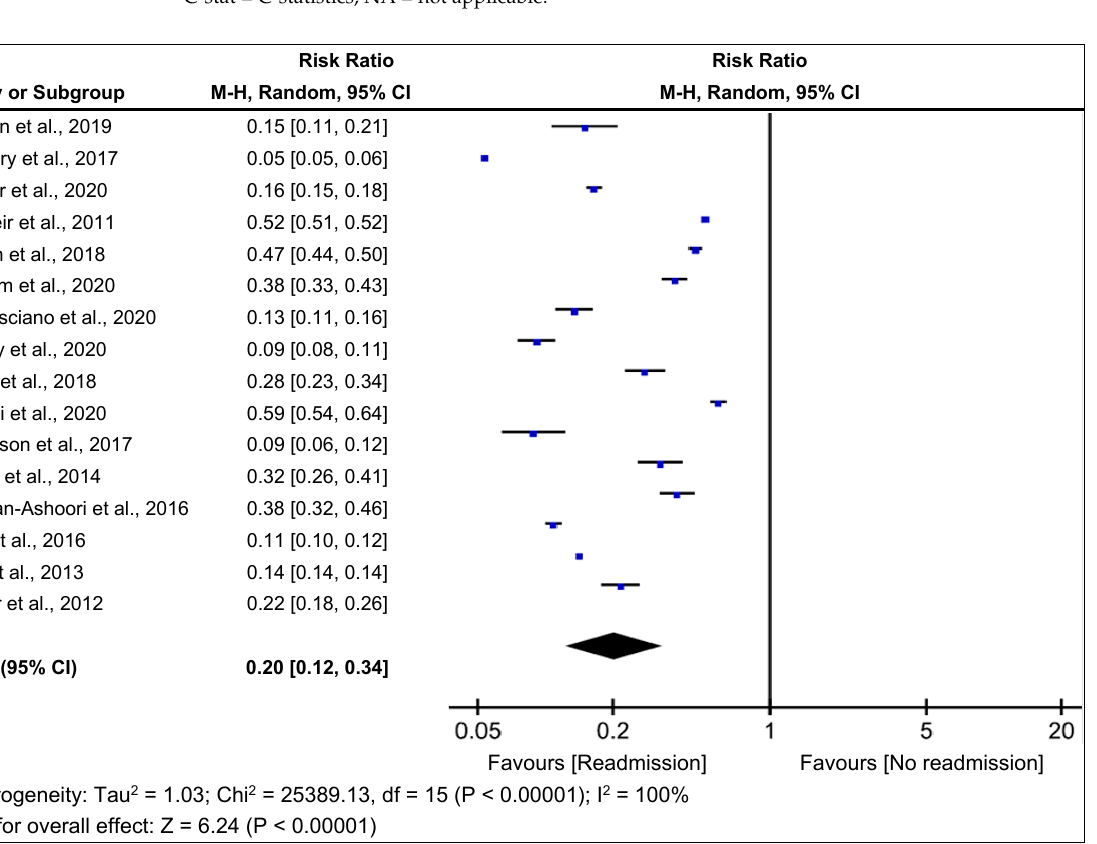
Figure 2. Forest plot of LACE Risk Ratio for 30-day hospital admissions with LACE index in overall studies [12–22,29–31]. Boxes indicate the risk ratios (RRs); whiskers, 95% CIs; diamonds, pooled RR of readmission; vertical straight lines, overall pooled RR of 1.00. M-H = Mantel-Haenszel; CI = confidence